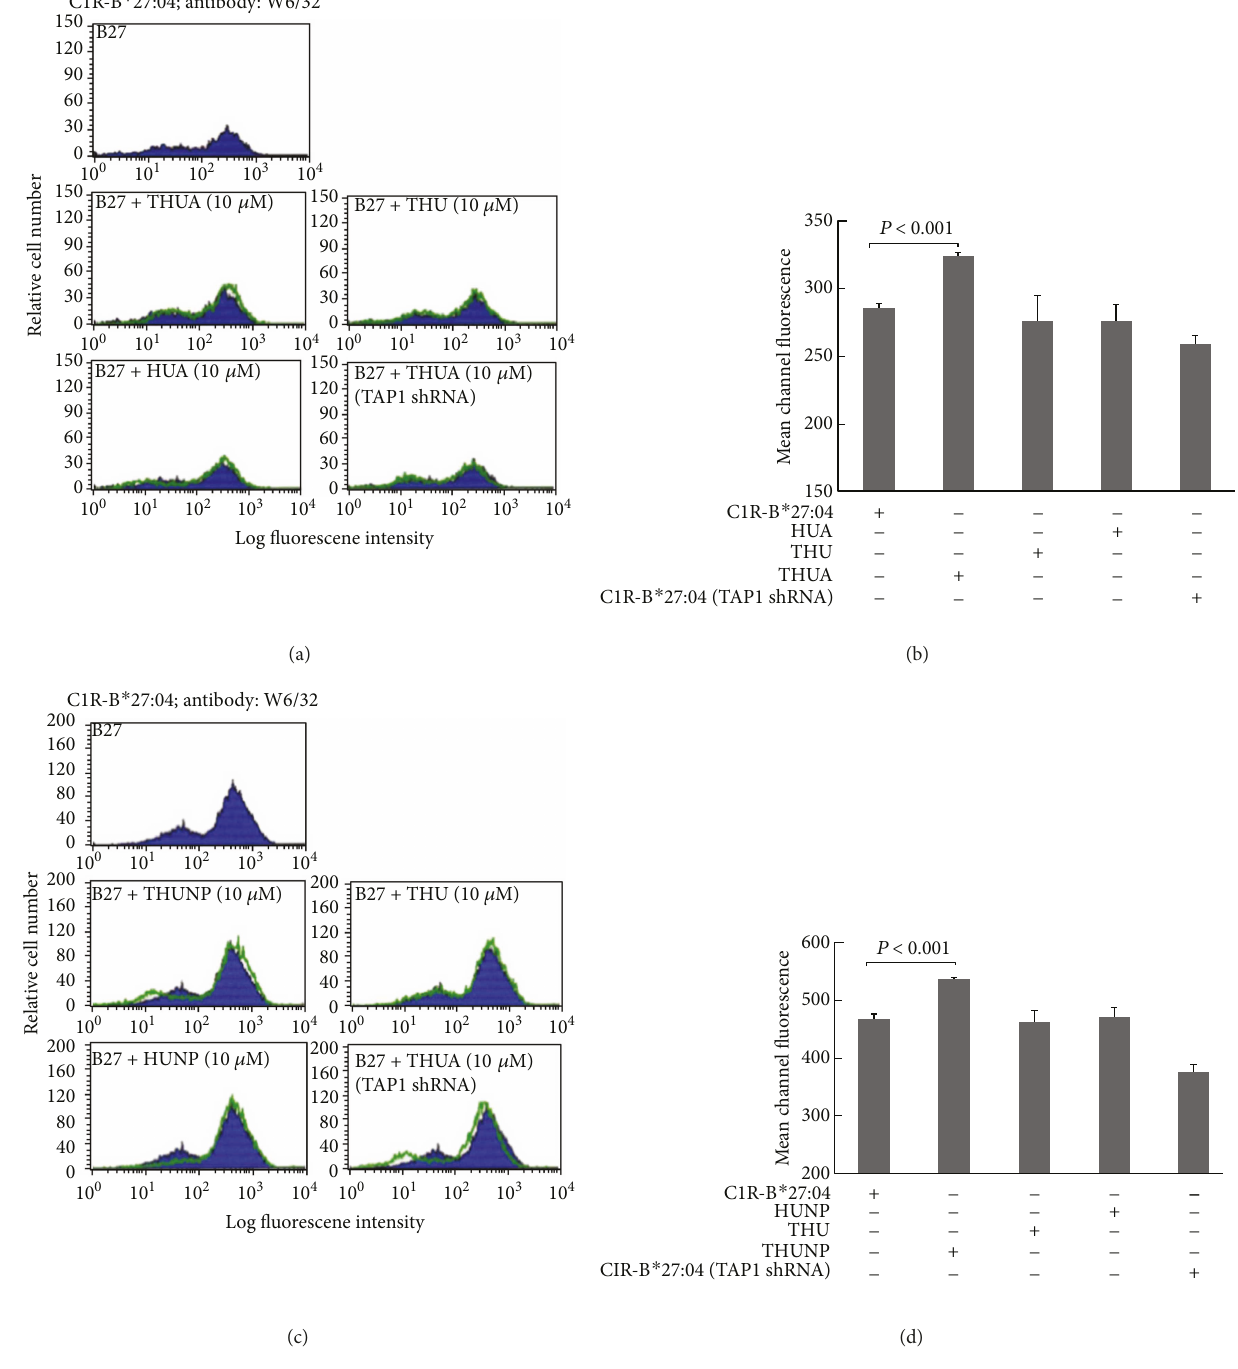
Figure 3: Treatment with either THUA or THUNP increases the antigenic peptide targeted to the cell surface of C1R-B ∗ 27:04. (a) Treatment m/KRGILTLKY complex presented at the cell surface of with THUA, but not with THU or HUA, increases the HLA-B ∗ 27:04 HC/ β 2 C1R-B ∗ 27:04, as detected by fl ow cytometry. Knockdown of TAP1 ruins the antigenic peptide, KRGILTLKY, presented on the cell surface. (b) Mean channel fl uorescence measured in (a) was averaged from three independent experiments (mean ± SD, n = 3 ). Values of mean channel fl uorescence measured from the large population of C1R-B ∗ 27:04 cells that display the high levels of HLA- B ∗ 27:04 on the cell surface were increased when cells were treated with THUA. (c) Treatment with THUNP, but not with THU or m/SRYWAIRTR complex presented at the cell surface, as detected by fl ow cytometry. HUNP, increases the HLA-B ∗ 27:04 HC/ β 2 TAP1 knockdown impairs the antigenic peptide, SRYWAIRTR, presented on the cell surface. (d) Mean channel fl uorescence measured in (c) is increased when C1R-B ∗ 27:04 cells were treated with THUNP. Values (mean ± SD, n = 3 ) measured from the high population of cells that display the high levels of HLA-B ∗ 27:04 on the cell surface are averaged from three independent experiments. Statistical signi fi cance was obtained by the Mann – Whitney U